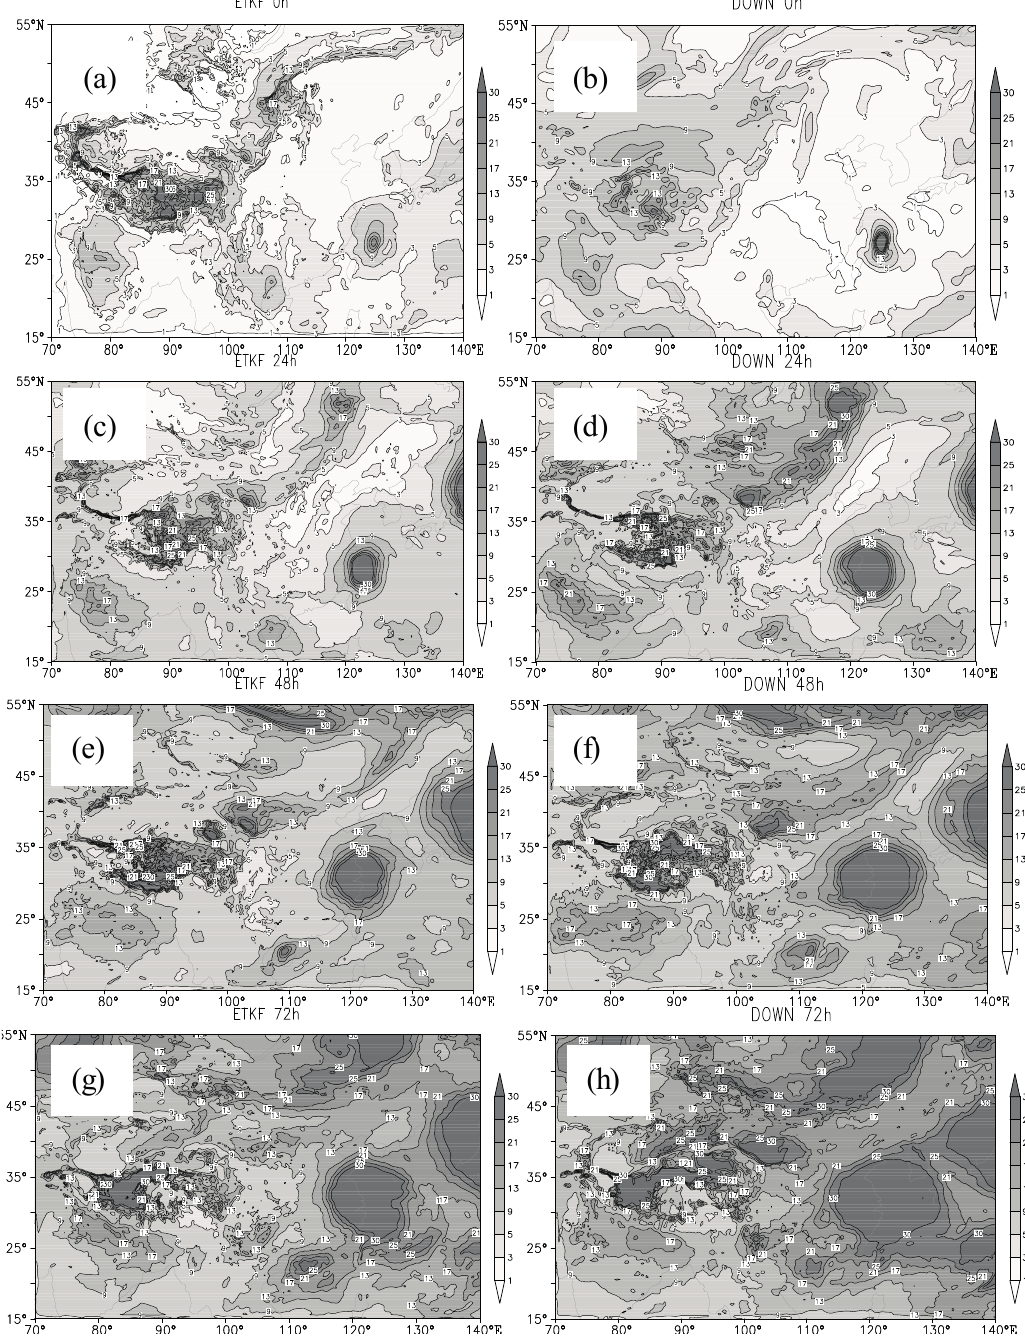
Figure 3. All members vertically averaged perturbation energy norm (unit:J/kg) at different forecast lead times, for ETKF and DOWN, respectively. ( a ) ETKF 00 h; ( b ) DOWN 00 h; ( c ) ETKF 24 h; ( d ) DOWN 24 h; ( e ) ETKF 48 h; ( f ) DOWN 48 h; ( g ) ETKF 72 h; and ( h ) DOWN 72